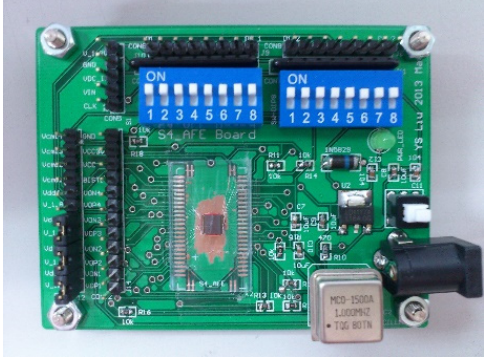
Figure 11. Evaluation board photo.